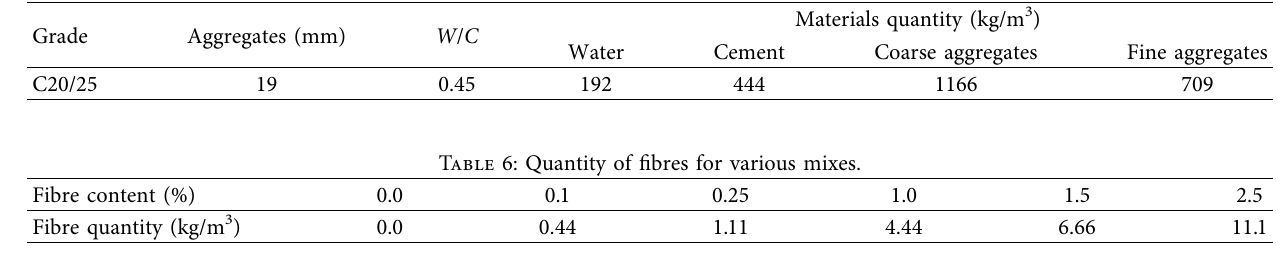
Table 5: Mixture proportions.